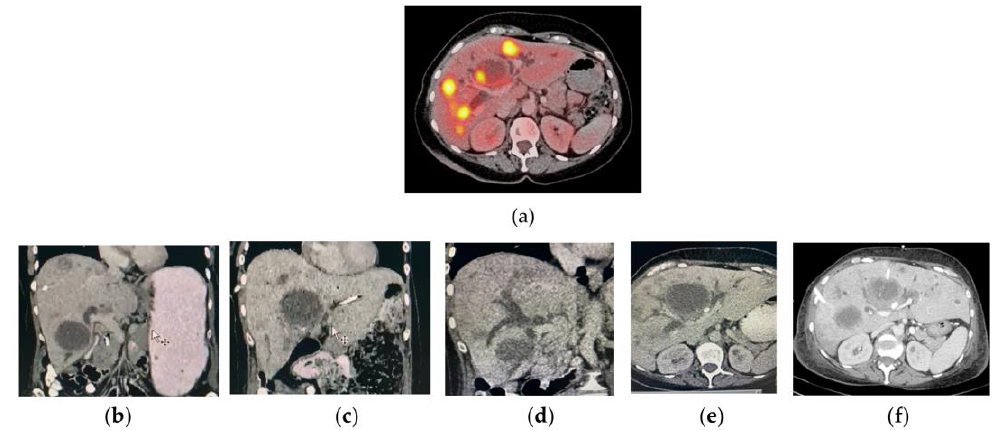
Figure A1. ( a ) PET/CT liver axial image of a patient with liver metastases of colorectal cancer